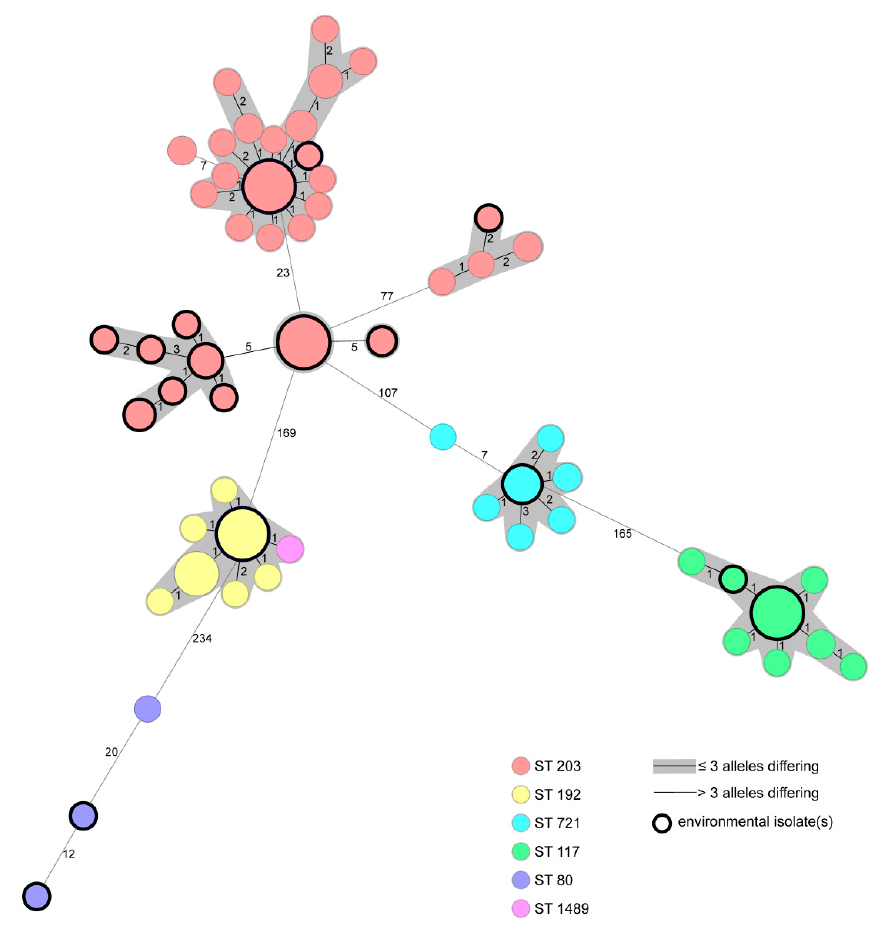
Figure 1. Minimum spanning tree of 150 VRE strains isolated from patients or environmental sampling points based on 1423 core genome multilocus sequence typing (cgMLST) target genes, pairwise ignore missing values. Every circle represents one genotype, the size of circles correlates with the number of identical genotypes. Di ff erent colors represent di ff erent MLST sequence types. Black bordered dots indicate environmental isolates. Grey coloring indicates close genetic relation ( ≤ 3 alleles di ff ering between two genotypes). Table 1. Distribution of van genes and multilocus sequence typing (MLST) sequence types (ST) in detected vancomycin-resistant enterococci (VRE) isolates derived from patients (P) and the hospital environment (E). MLST ST van